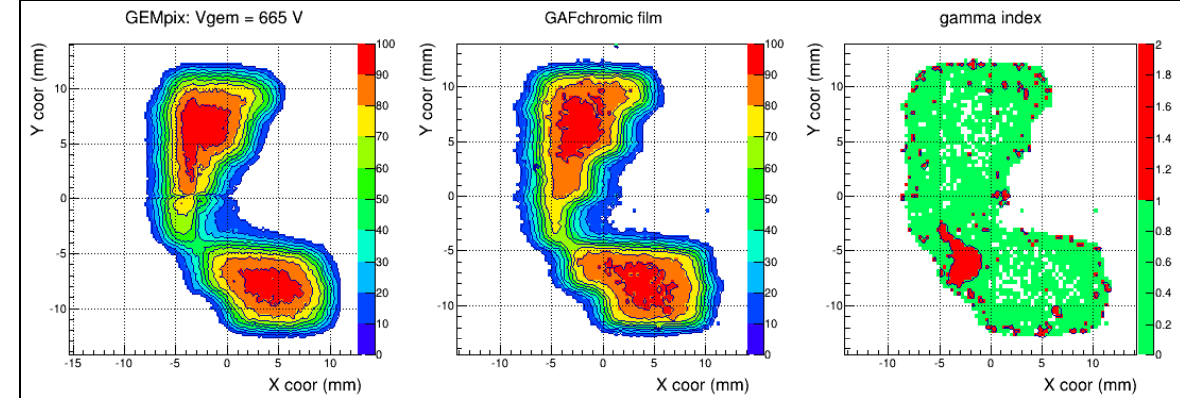
Figure 7. A dose distribution measured with the GEMPix ( left ) is compared to a gafchromic film measurement with a spatial resolution of 160 µm ( centre ) for a 6 MV radiation therapy field: the relative dose is color-coded. The gamma index distribution ( right ) obtained is less than one for 90.5% of the data points [21].